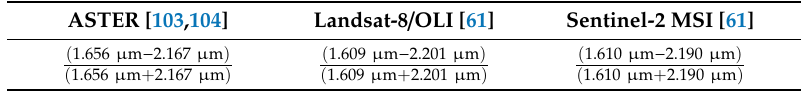
Table 2. The normalized hydrothermal alteration spectral index (NHASI) formulation for ASTER, Landsat-8 / OLI, and Sentinel-2 MSI data, expressed in wavelengths.